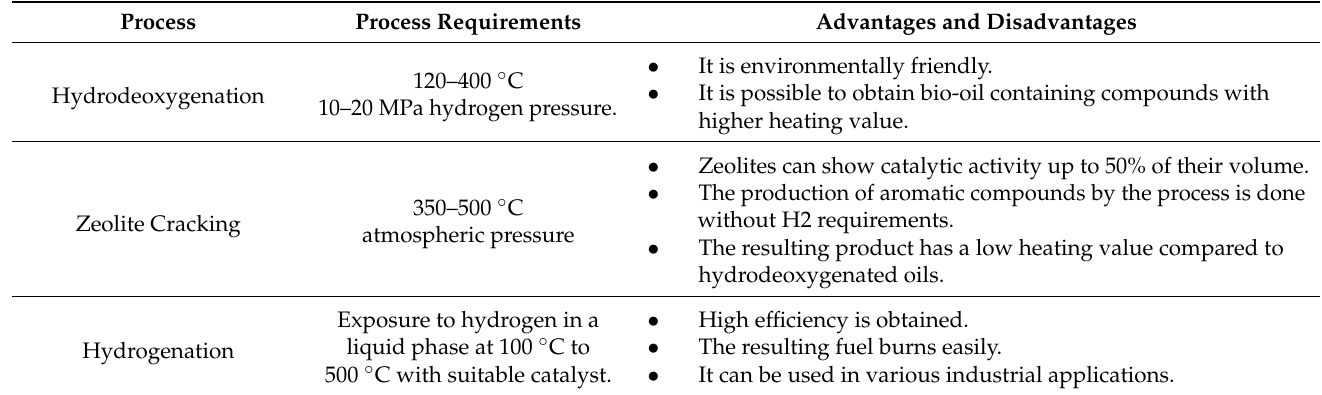
Table 2. Comparison of the catalytic pathways used to convert biomass to